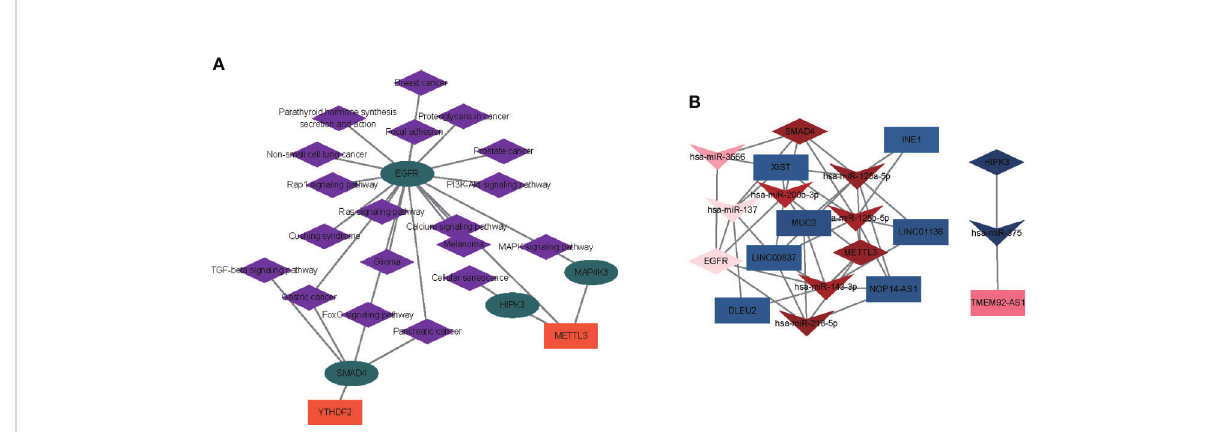
FIGURE 7 Construction of an m6A regulator – target gene – pathway network and the ceRNA network. (A) A m6A regulator – target – pathway network in MEbrown. Orange rectangles present m6A regulators, turquoise ellipses represent m6A targets, and purple diamonds represent pathways. (B) Two ceRNA networks of OP. One network contained lncRNA TMEM92-AS1, has-miR-375, and HIPK3. Another ceRNA network included seven lncRNAs (XIST, MUC2, NOP14-AS1, INE1, LINC01136, LINC00837, and DLEU2), seven miRNAs (hsa-miR-125a-5p, hsa-miR-125b-5p, hsa- miR-137, hsa-miR-143-3p, hsa-miR-200b-3p, hsa-miR-218-5p, and hsa-miR-3666), and three mRNAs (SMAD4, METTL3, and EGFR). Rectangles represent lncRNAs, quadrangles represent miRNAs, and prisms represent